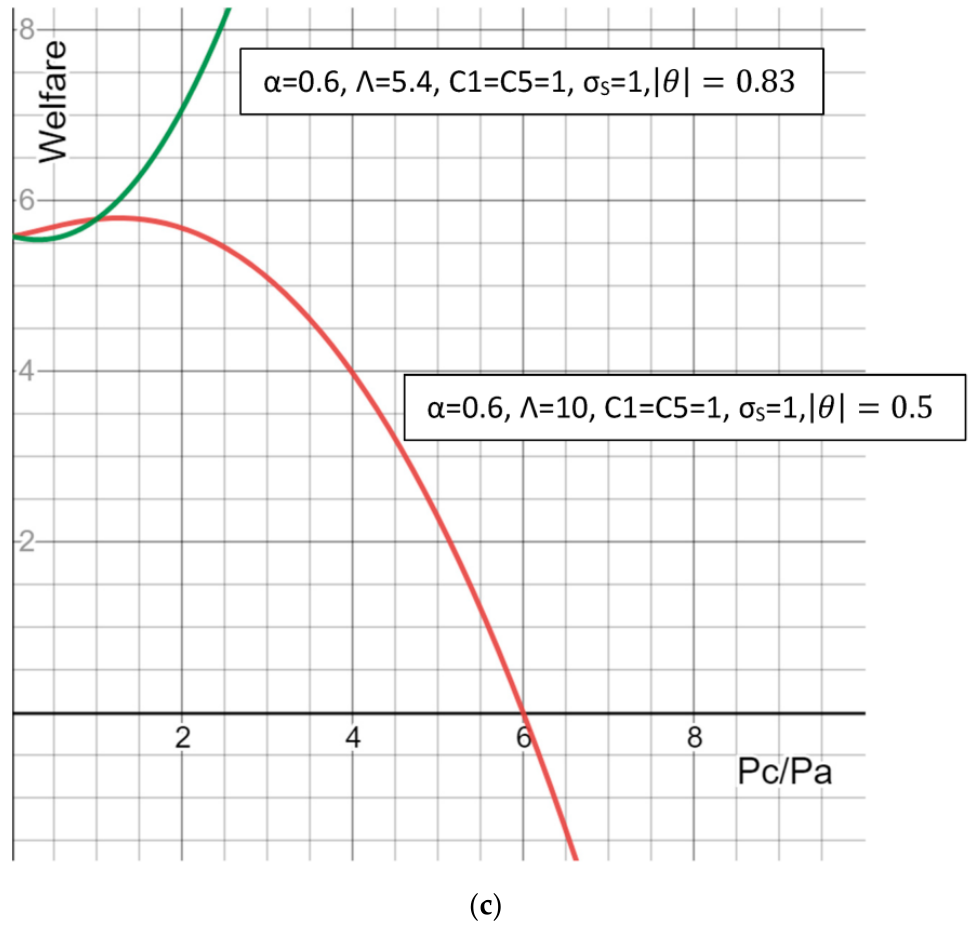
Figure 6. ( a ) The Relationship between CF and Social Welfare. Source: Authors’ numerical simula- tions. ( b ) The Relationship between CF and Social Welfare. Source: Authors’ numerical simulations. ( c ) The Relationship between CF and Social Welfare. Source: Authors’ numerical simulations.